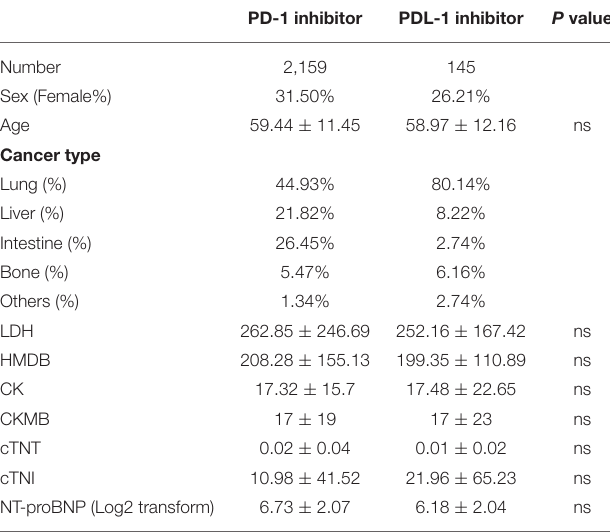
TABLE 1 | Baseline information of patients receiving PD-1 or PDL-1 inhibitor.